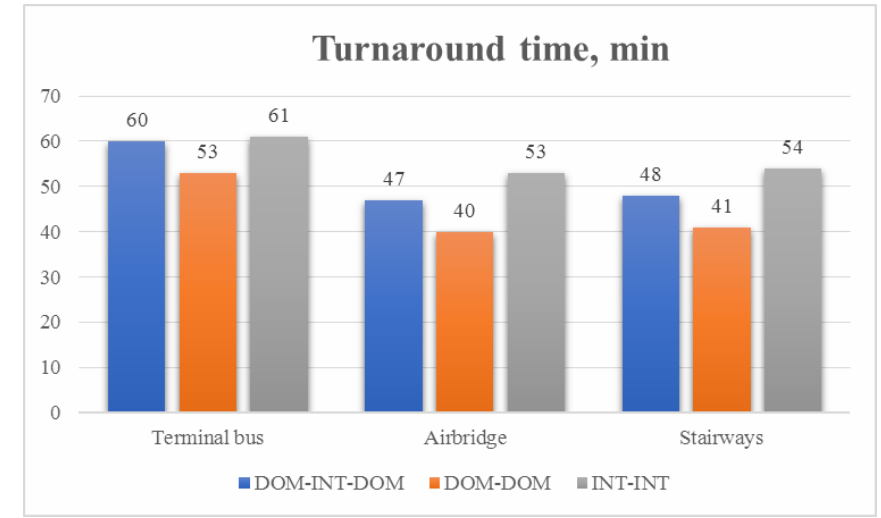
Fig. 4. Turnaround time for different